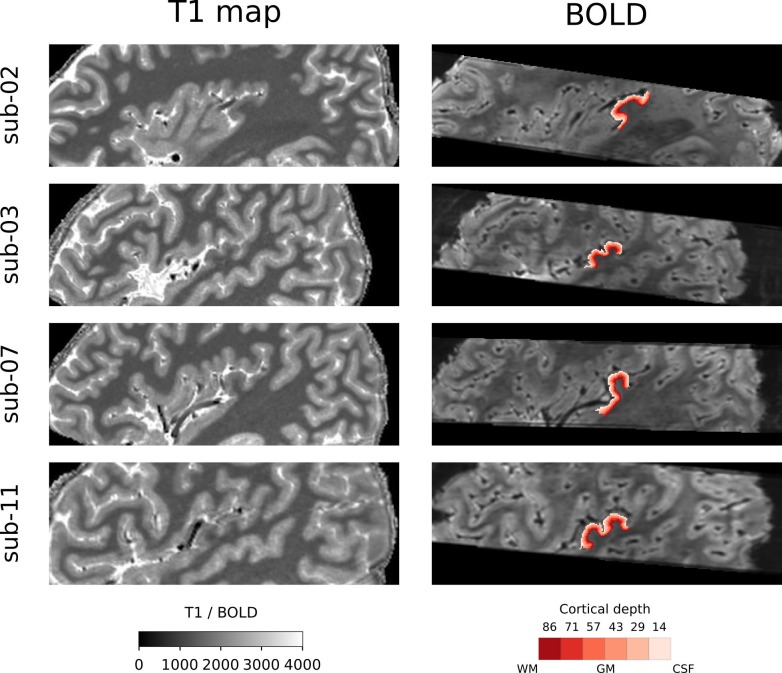
Segmentation and coregistration.Sagittal section of T1 structural images (left), the corresponding coregistered mean EPI images of four representative participants. The definition of the six laminae is overlaid in A1.